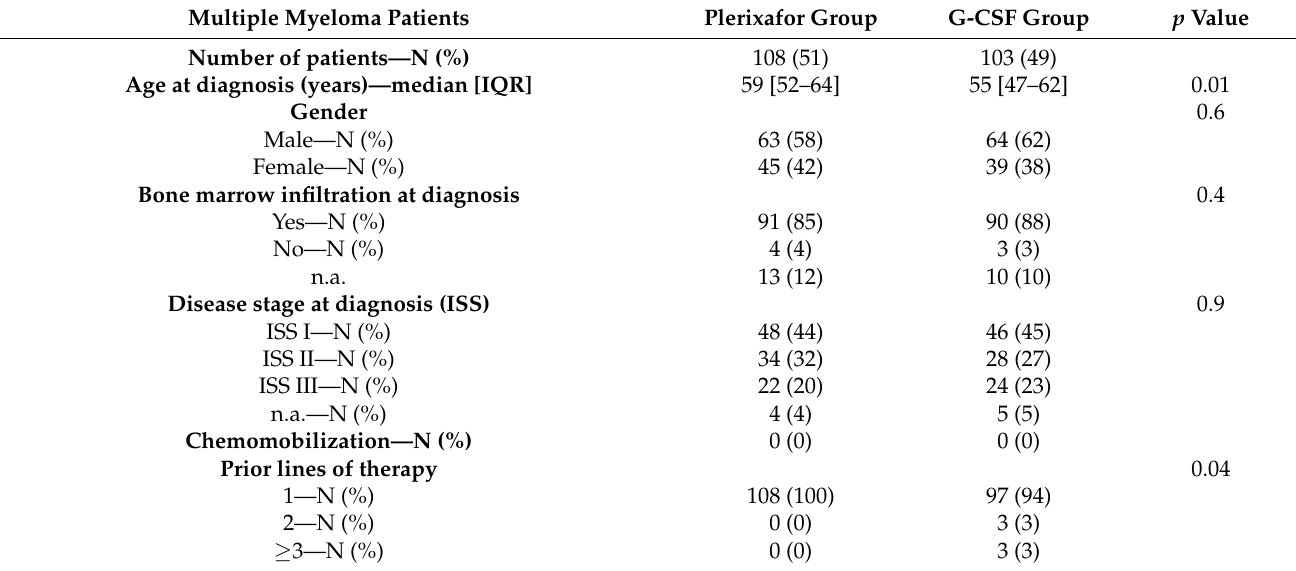
Table 1. Multiple Myeloma patients and disease